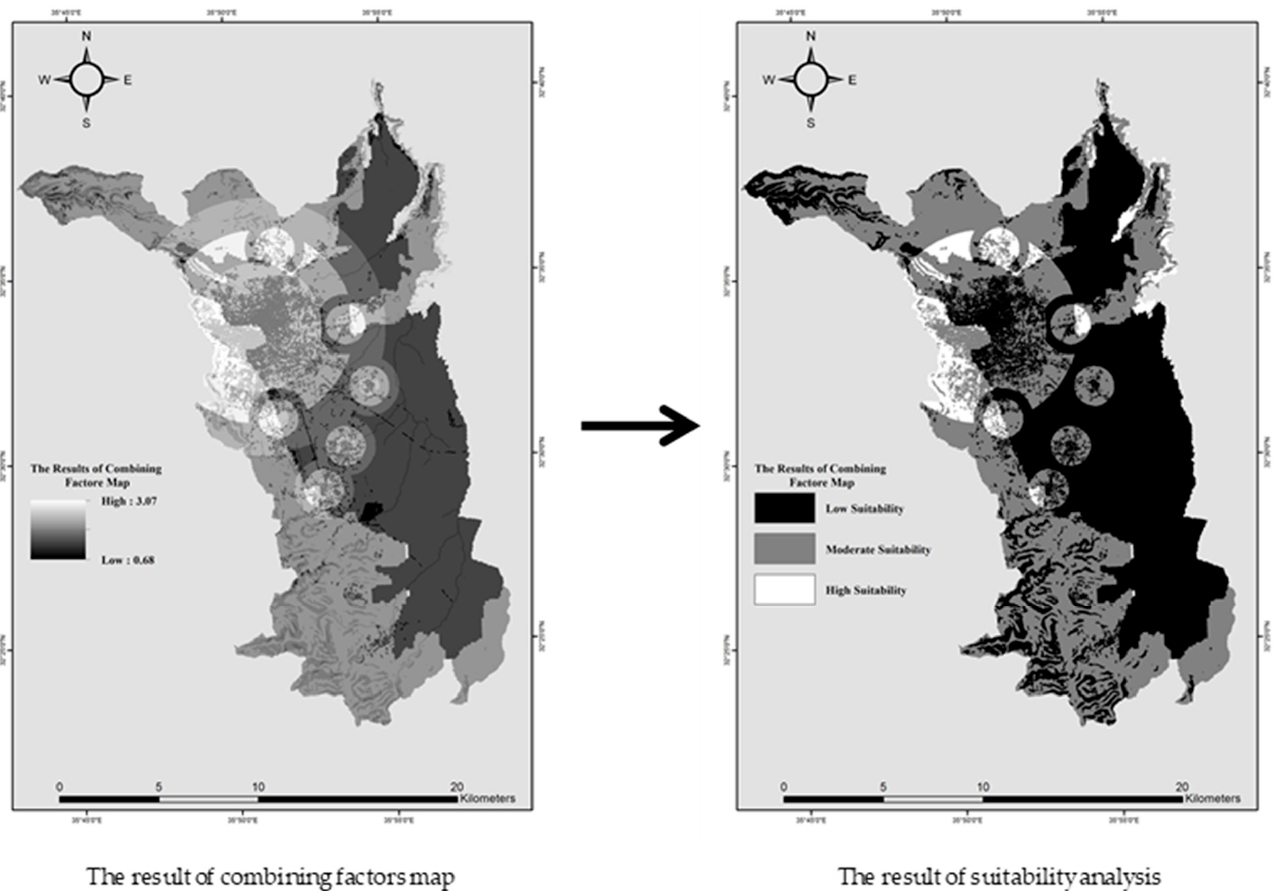
Figure 14. The result of combining factors and suitability analysis. Table 3. Criteria reclassification and weighting.